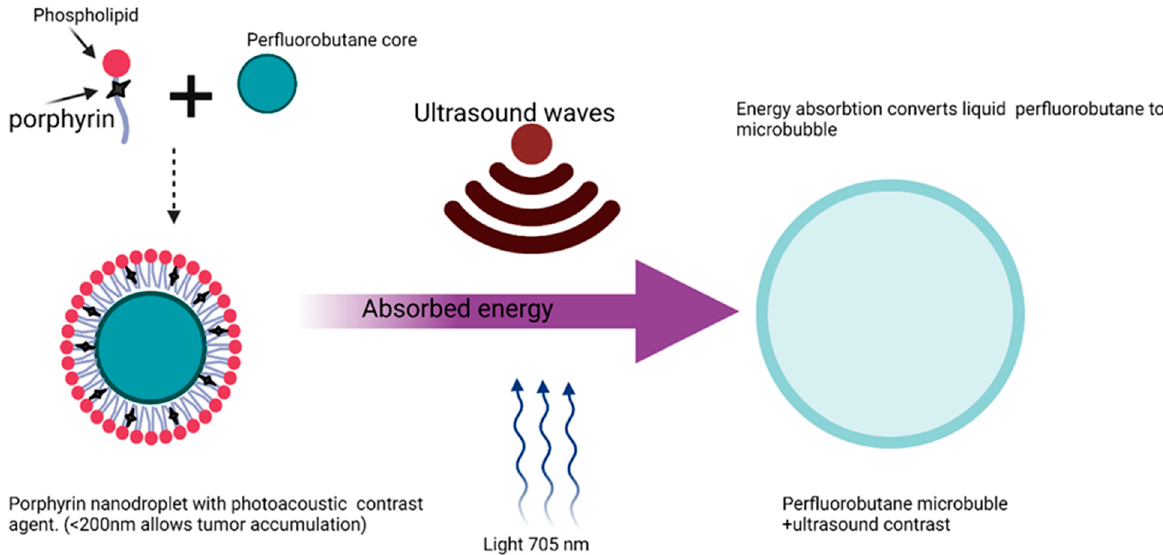
Figure 8. Phase conversion strategy of microbubble ultrasound-based delivery. Porphyrin nanodroplets provides photoacoustic contrast due to the strong optical absorption of porphyrin. The absorption of photons or acoustic energy induces a phase transition of perfluorobutane from liquid to gas microbubble. This system can be loaded with a payload for delivery through cavitations induced by the hyper-echogenic and nonlinear acoustic properties of microbubbles. Modified from Ref. [126] and created with BioRender.com. Accessed 15 March 2022.